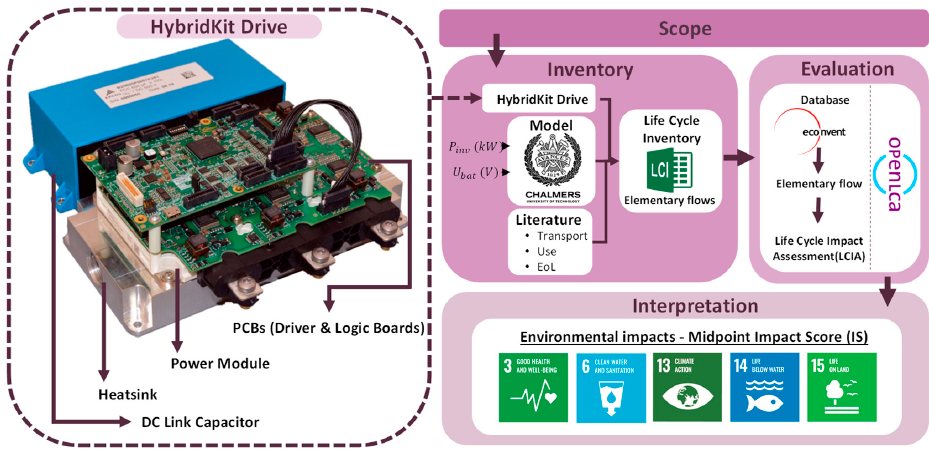
Figure 1. Principles of the LCA based on the study data. The 4 LCA steps correspond to the 4 highlighted areas.